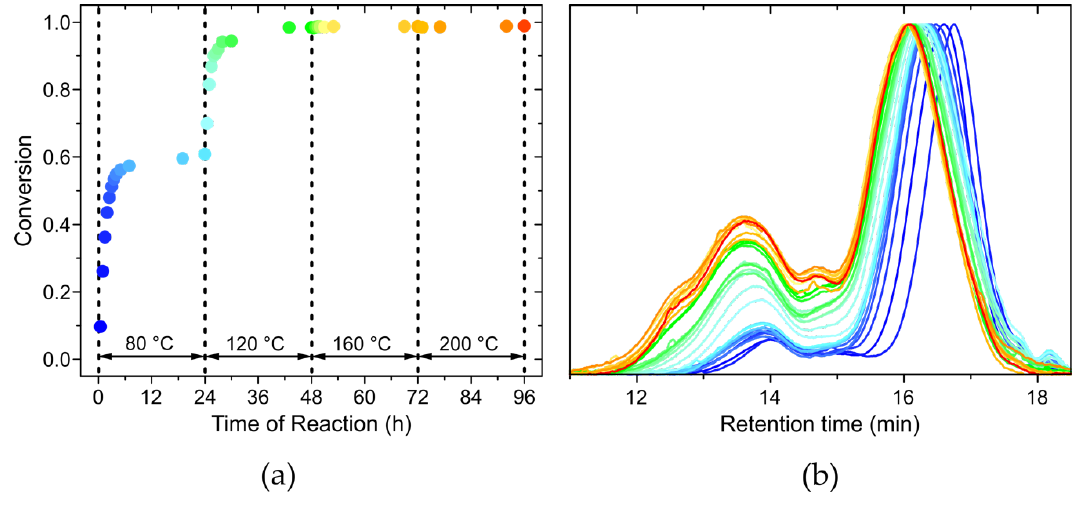
Figure 6. ( a ) progress of the monomer conversion ( p ) as a function of the reaction time. The temperature increments after 24 h from room temperature to 200 °C are indicated by the region separated by dashed lines; ( b ) gel permeation chromatograms of the aliquots taken during the reaction illustrate the evolution of the trimodal molar mass distribution over the course of the polymerization. The color code of the curves coincides with the colored dots in Figure 6a.